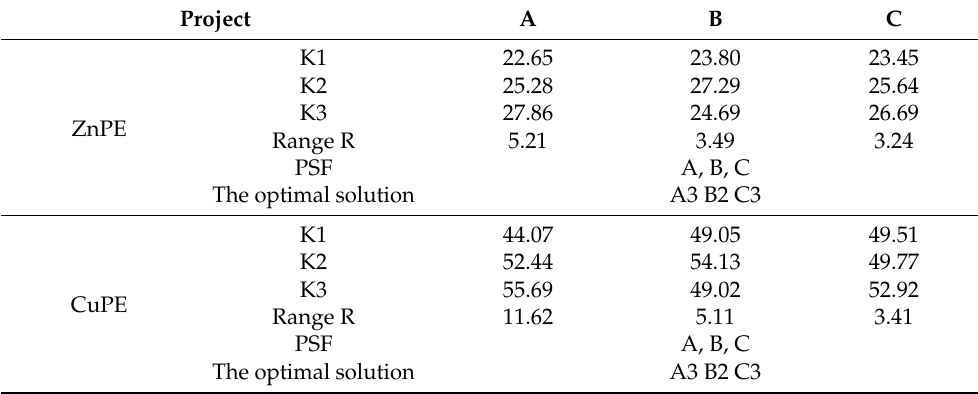
Table 7. Range analysis of the passivation effect of Zn and Cu in the biogas residue from pig manure anaerobic